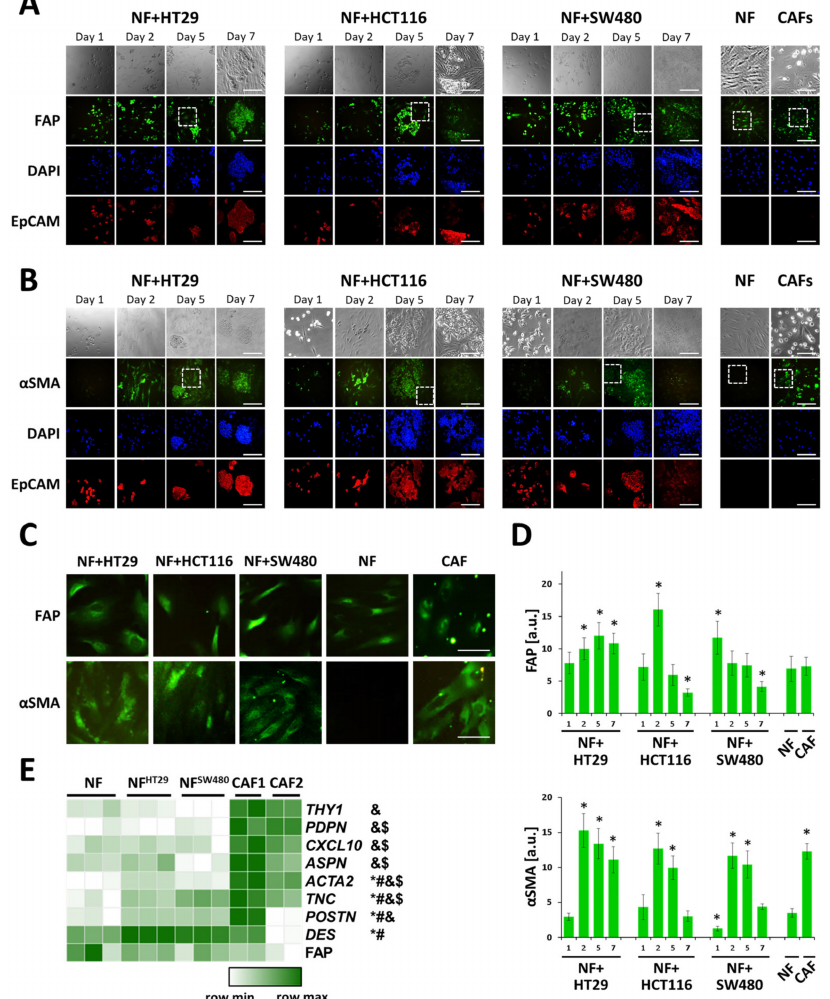
Figure 2. Activation of normal fibroblasts upon co-culturing with colorectal cancer cells. Immunofluorescence staining of the co-cultures of HT29, HCT116, or SW480 cells with normal fibroblasts (NFs) on days 1, 2, 5 and 7, NFs and patient-derived CAFs for ( A ) FAP, fibroblast activation protein α 1, and ( B ) aSMA, α -smooth muscle actin. Cells were additionally stained against 4 (cid:48) ,6-diamidino-2-phenylindole (DAPI; nucleus; blue) and EpCAM (epithelial cell adhesion molecule; red). Scale bar, 400 µ m ( C ) A higher magnification of the areas corresponding to the dashed square in ( A ), ( B ). Scale bar, 100 µ m. ( D ) Quantification of FAP and aSMA staining (averaged fluorescence intensity of fibroblasts, at least eight regions of interest (ROIs) per condition with 2–5 cells in each ROI). Mean ± SD. *, p < 0.05 from NF. ( E ) Gene expression heatmap of cancer-associated fibroblast (CAF) markers with di ff erential activity in various types of fibroblasts. NFs—normal skin fibroblasts, NF HT29 —normal fibroblasts isolated from co-cultures with HT29 cancer cells on day 5, NF SW480 —normal fibroblasts isolated from co-cultures with SW480 cancer cells on day 5, CAF1-2—colon cancer-associated fibroblasts (cultures 1 and 2). p-adj < 0.05 for gene expression in NFs compared to *, NF HT29 ; #, NF SW480 ; &, CAF1; $,